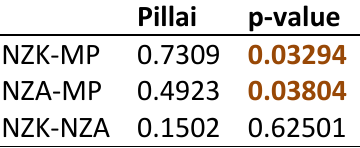
Table 13. Results of the pairwise multivariate analysis of variance realised on the PC1-13 (based on EFA coefficients) versus sites. Significant values are shown in